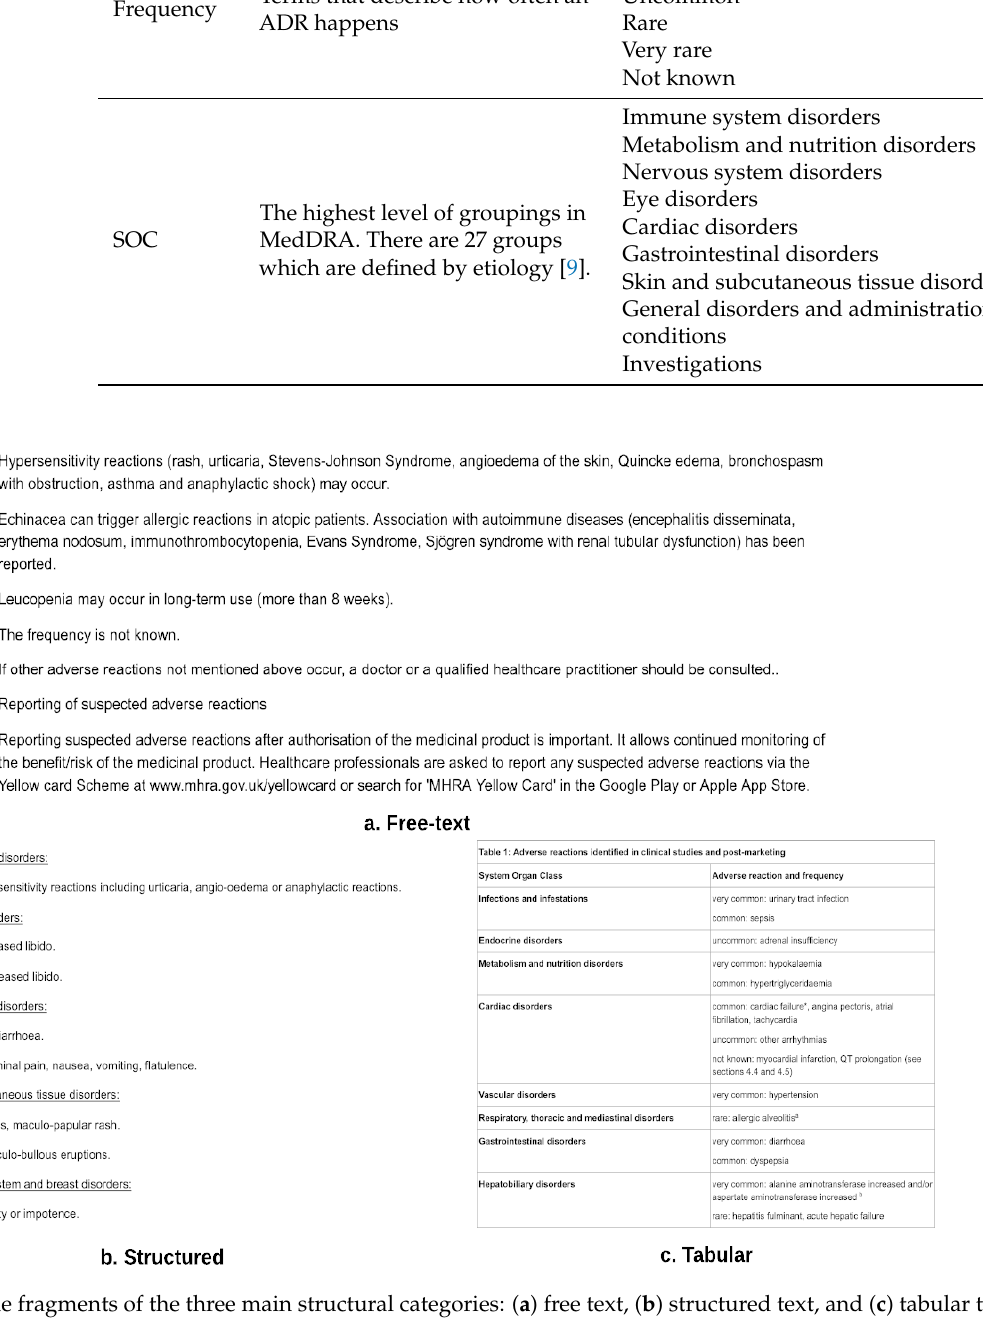
Figure 4. Example fragments of the three main structural categories: ( a ) free text, ( b ) structured text, and ( c ) tabular text.